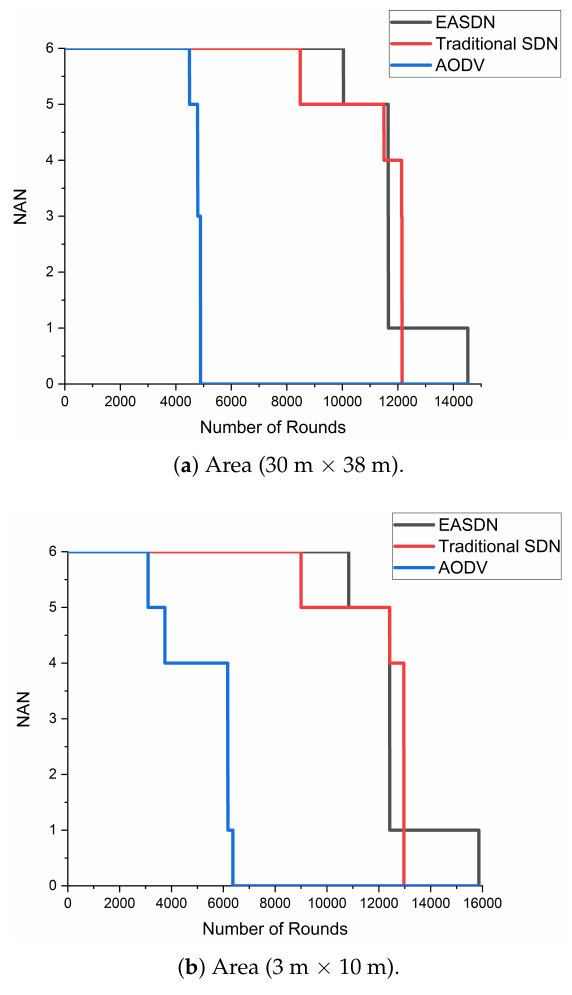
Figure 14. Alive nodes vs number of